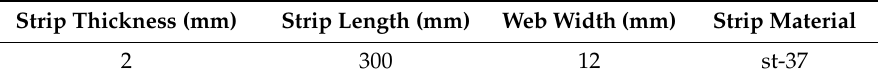
Figure 9. The pair of rollers. Table 4. Roll forming parameters of